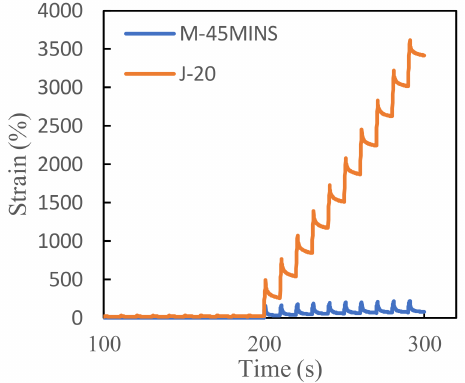
Figure 6. Typical creep and recovery cycle during multiple stress creep recovery (MSCR)